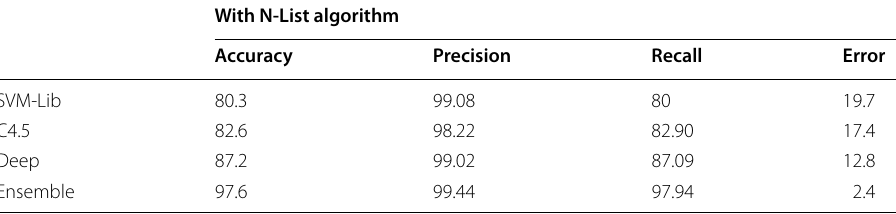
Table 14 Accuracy, precision, recall and error rate of the SVM-Lib, C4.5 and deep neural network algorithm for basket analysis with the N-LIST